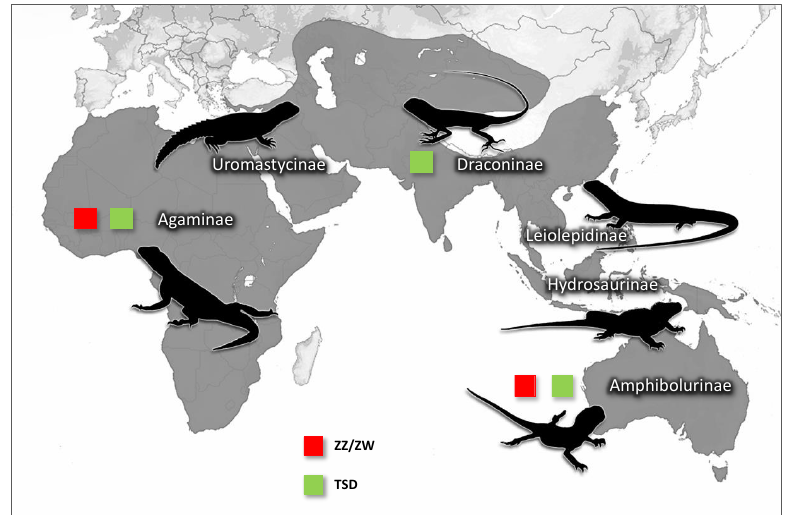
Figure 1. Estimated distribution of the agamid subfamilies together with known sex determination mechanisms [6,17,20,21,24,31,34 – 49]. The species of the subfamily Draconinae are distributed over South and Southeast Asia, Agaminae across Africa and Asia, Amphibolurinae across Australia, Papua New Guinea and Southeast Asia, Hydrosaurinae across Papua New Guinea, the Philippines and Indonesia, Leiolepidinae across Southeast Asia and Uromastycinae across Africa and South Asia. TSD—temperature dependent sex determination, ZZ / ZW—female heterogamety. Obligatory parthenogenesis has been reported in several species of the subfamily Leiolepidinae, although the sex determination system is not known in this